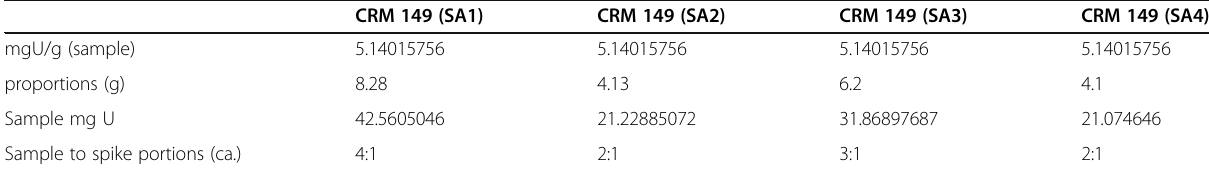
Table 3 CRM 149 sample proportions to duplicate the sample-spike mixtures (SA1, SA2, SA3,